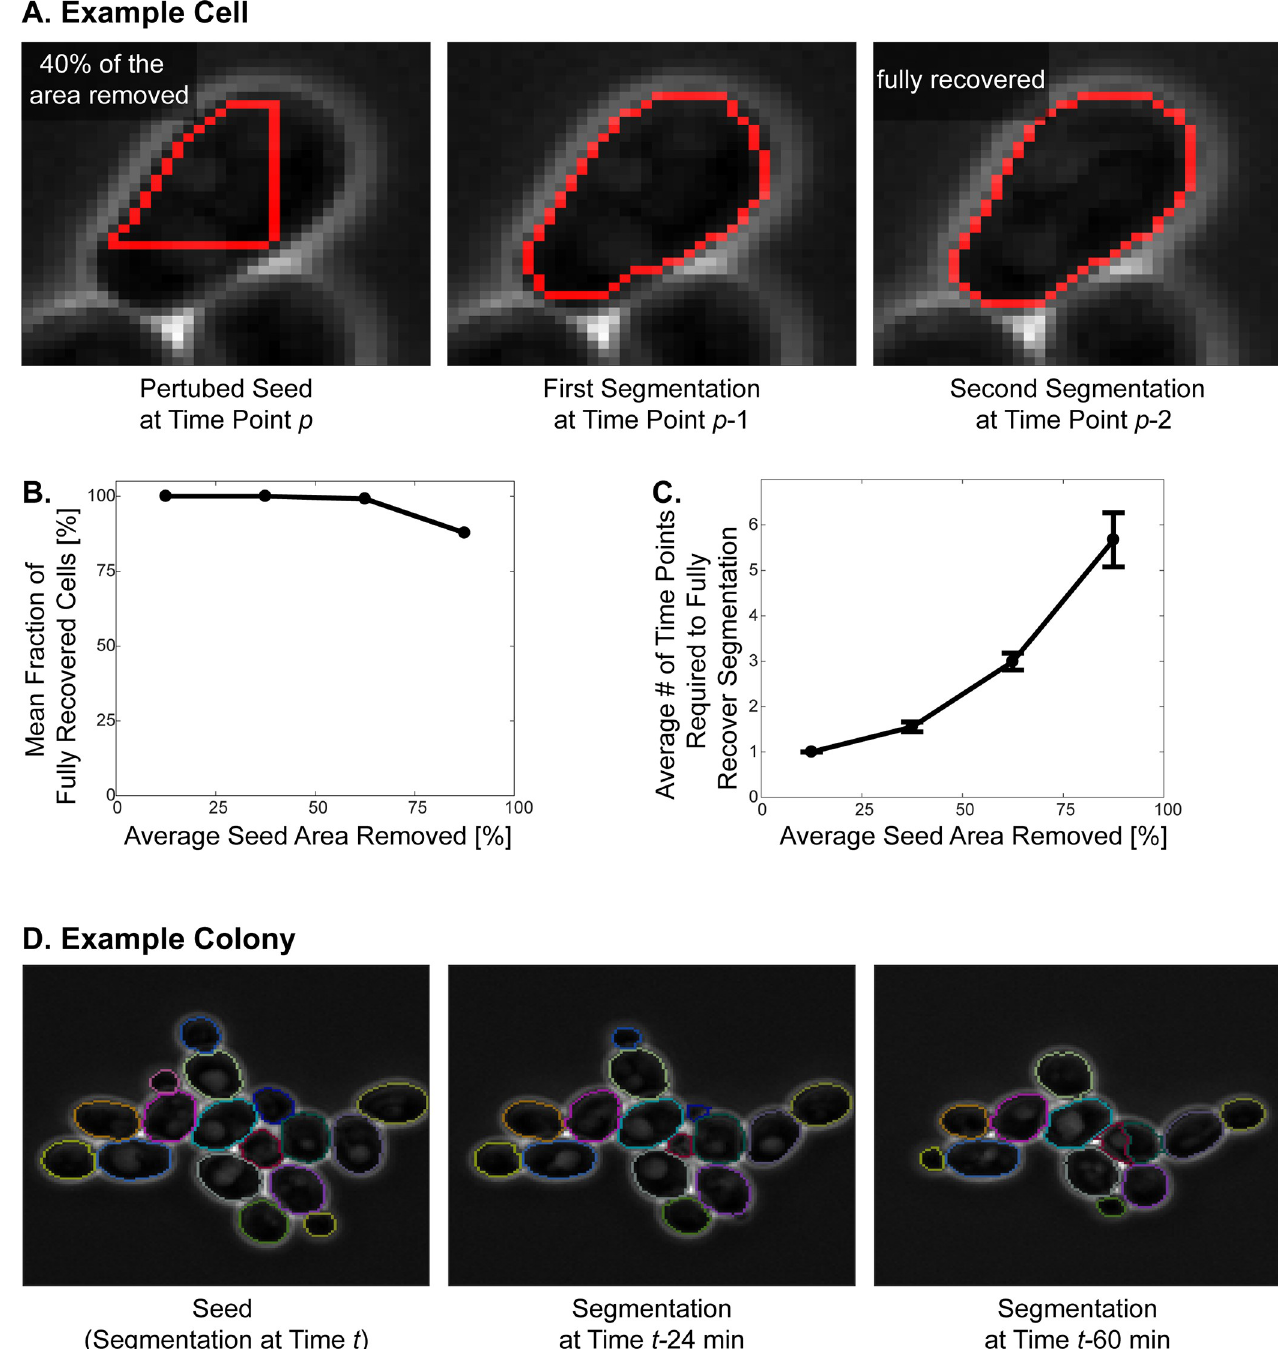
Fig 7. Robustness of the segmentation algorithm. Robustness to errors in the seed. (A) Example cell: The seed of the example cell is perturbed by randomly removing 40% of the seed. The algorithm uses this perturbed seed to segment the cell at time point p -1 and recovers the cell with only minor mistakes. The algorithm fully recovers the cell in two time points. Note that the algorithm segments the cells backwards in time, thus time points (i.e. frame numbers) are decreasing. (B) The seeds of 340 cells were perturbed by randomly removing 10–90% of the seed. The cells are grouped based on the severity of perturbation, i.e. percent seed area removed, in 25% increments. Mean fraction of fully recovered cells is plotted for each group. Note that out of 340 cells, only 9 of them were not recovered by the algorithm. (C) The cells are grouped based on the perturbation in 25% increments and the average number of time points required to fully recover the correct cell segmentation is plotted for each group. Number of time points required to fully recover the cells increase with the severity of the seed perturbation. The error bars show standard error of the mean. Robustness to time interval between frames. (D) Example colony used for the quantification presented in Table 4. The correct segmentation at time t is used as a seed to segment the images taken at t-24 min and t-60 min. All cells are